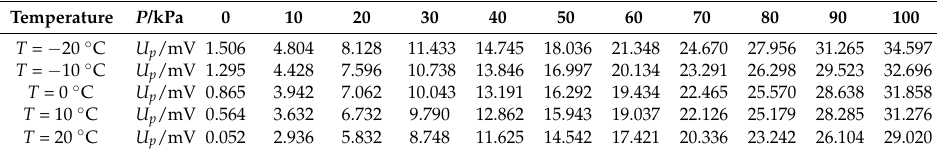
Table 1. The calibration sample data of PS1/PS2 sensors for the training of the GA-WNN, which are obtained with pressures from 0 to 100 kPa and with temperatures from − 20 to 20 ◦ C.